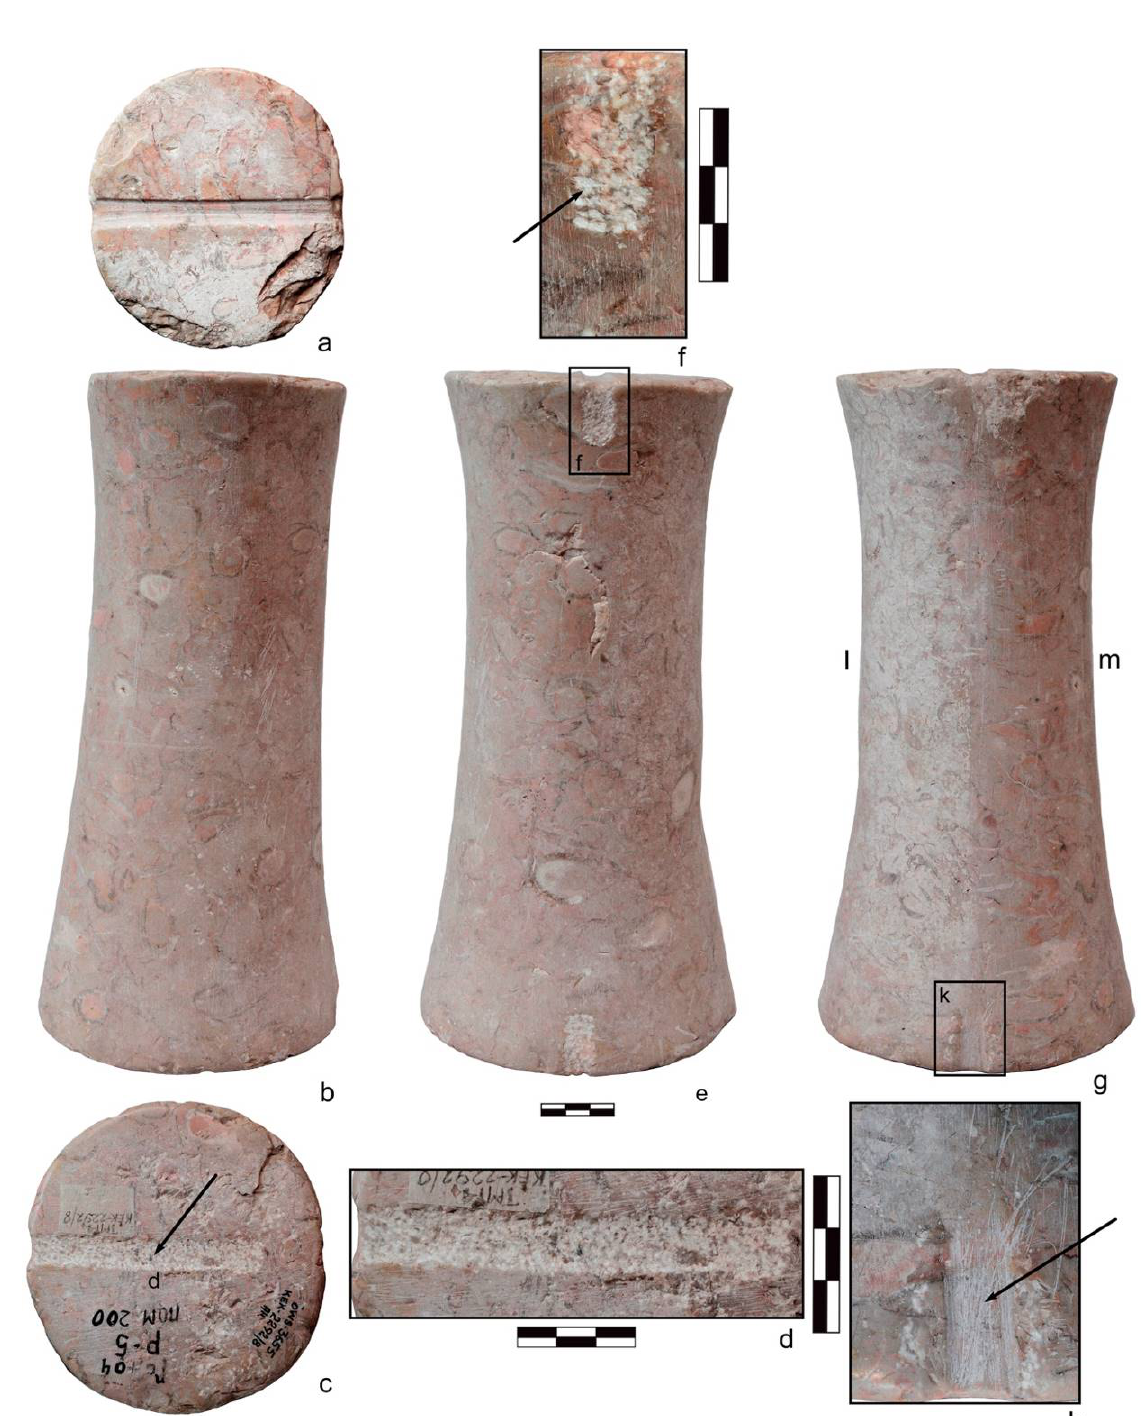
Figure 16. A miniature column from Gonur Depe with traces of secondary processing (from the depositories of the National Museum of Turkmenistan, Ashgabat): a. top base with traces of percussion; b, e, g. side; c. bottom base with traces of pecking in the groove; d, f. traces of pecking; k. traces of grinding; l. ground side; m. polished side. Scale bar is 3 cm long, separated into three 1 cm